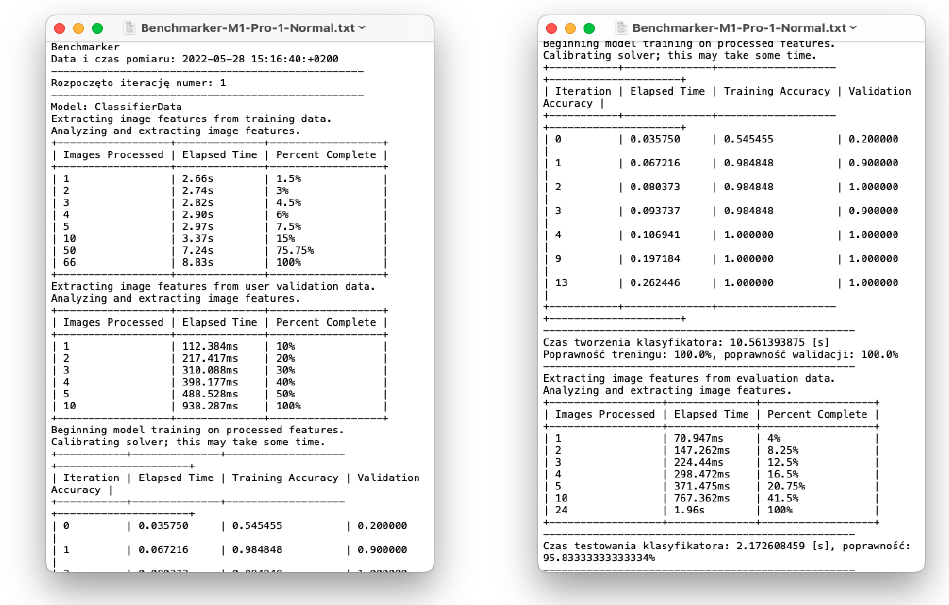
Figure 11. Fragments of the output for the measurement results of the ‘M1 Pro’ computer, per- formed using the ‘ClassifierData’ dataset. Left—beginning of the measurement; right—during the measurement process.